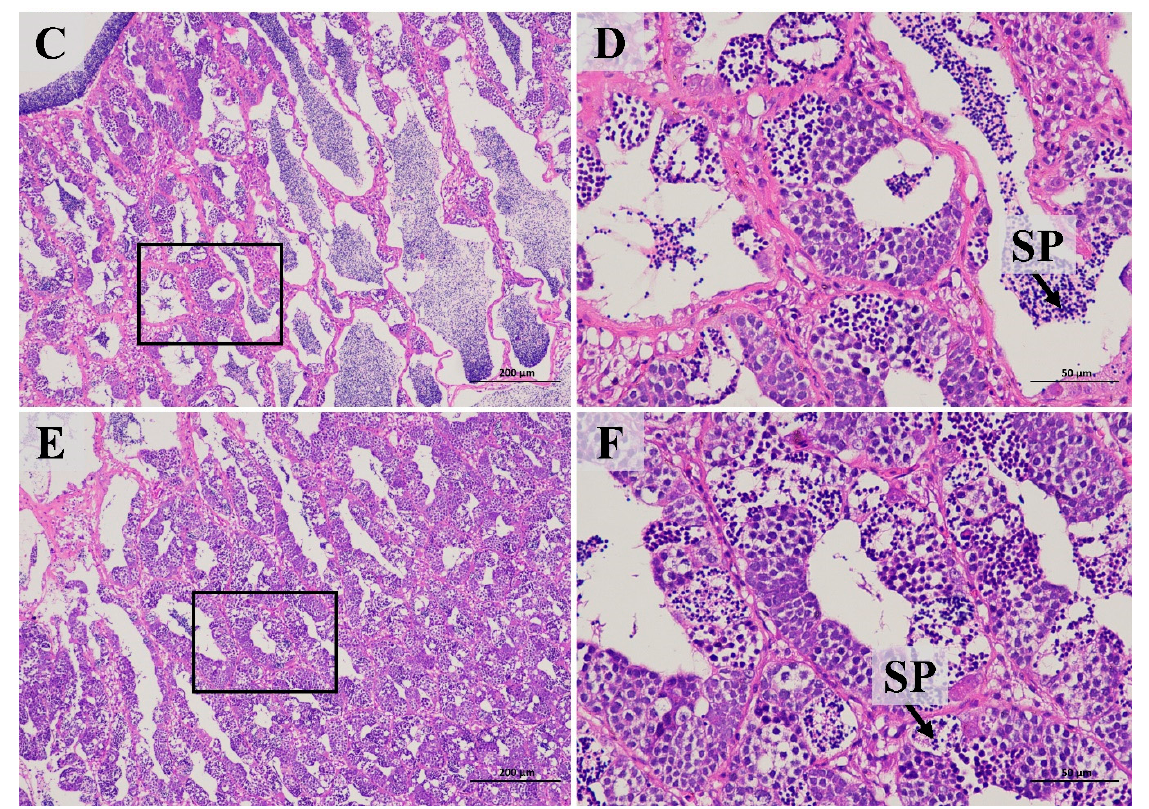
Figure 4. Representative sections of testis tissues from male Nile tilapia with knocked-down amh in: ( A ) control group at 100× and ( B ) 400×; ( C ) negative control group at 100× and ( D ) 400×; and ( E ) treatment group at 100× and ( F ) 400×. SP: sperm. Table 2. Fish body weight, gonad weight, and gonadosomatic index (GSI) of each group.